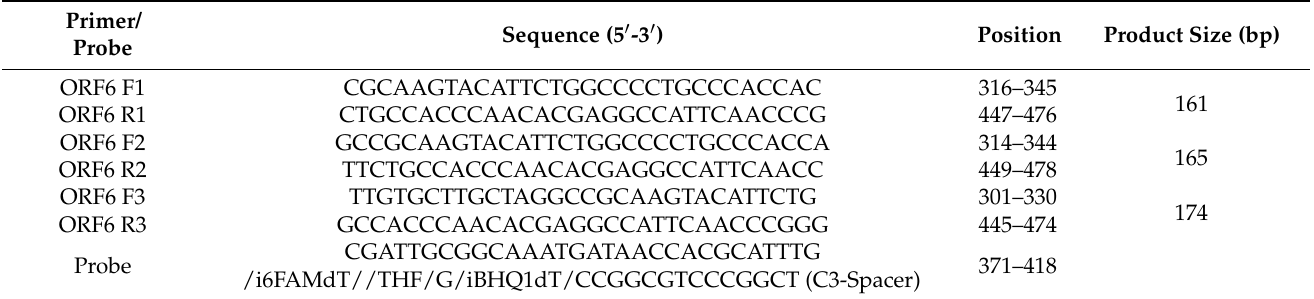
Table 1. Primers and probe used in this